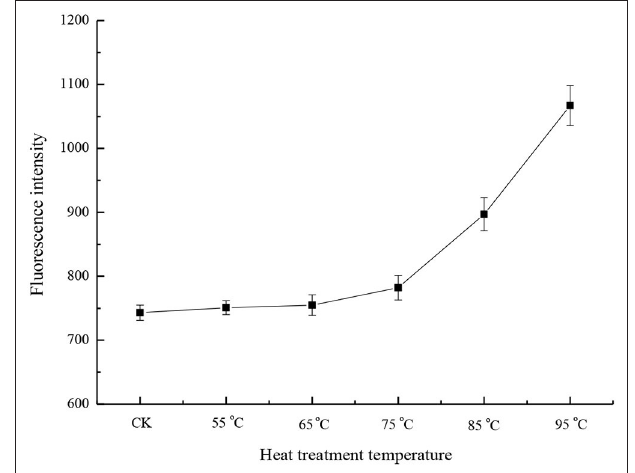
FIGURE 1 | Sulfhydryl content of different heat-treated skim milk. CK, skim milk without heat treatment.